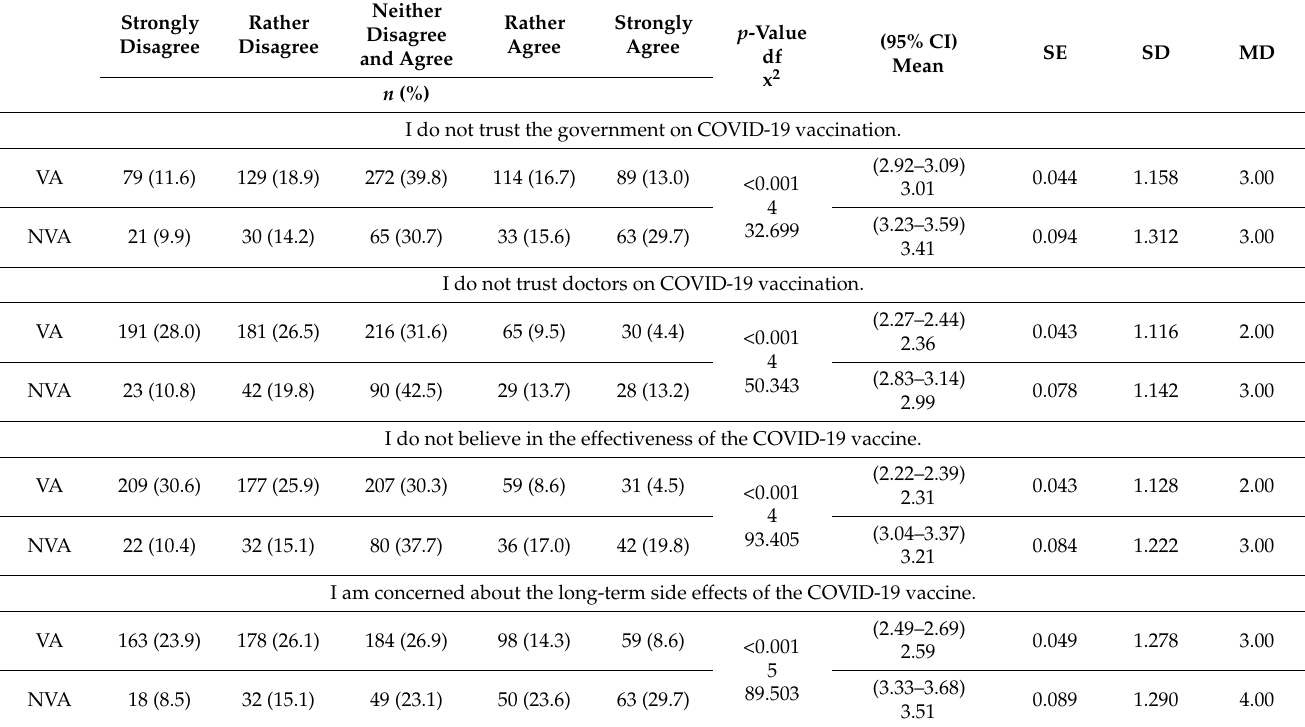
Table 10. Athletes’ concerns and beliefs related to COVID-19 vaccination and the COVID-19 pandemic broken down by vaccinated and unvaccinated ( n = 895).